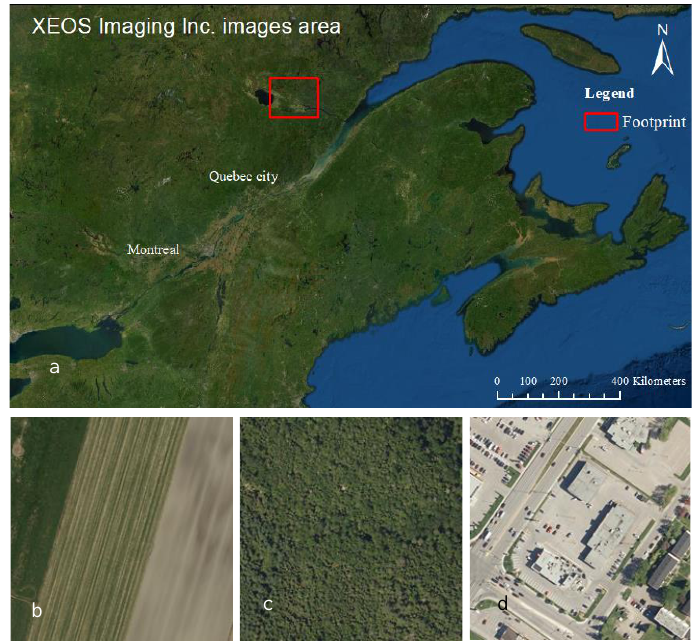
Figure 2. Map ( a ) and examples of airborne imagery. Agriculture ( b ), forest ( c ), urban ( d ). Service Layer Credits: Esri, Maxar, GeoEye, Earth star Geographics, CNES/Airbus DS, USDA, USGS, AeroGRID, IGN, and the GIS User Community.